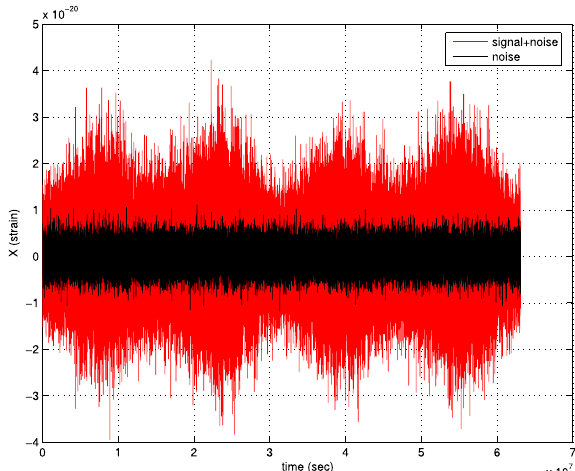
Fig. 40 The time-domain output of a particular Michelson combination, X ( t ) , of the LISA data over a 2- year period. The contribution from the detector noise is shown in black . The combined output, consisting of both detector noise and the confusion noise from the Galactic population of compact white-dwarf binaries, is shown in red . The modulation in the amplitude is due to the time-varying orientation of the LISA constellation as it performs a ‘cart-wheel’ in its 1-year orbit around the Sun (Fig. 39). The amplitude of the output is largest when the main lobes of LISA’s antenna pattern points in the general direction of